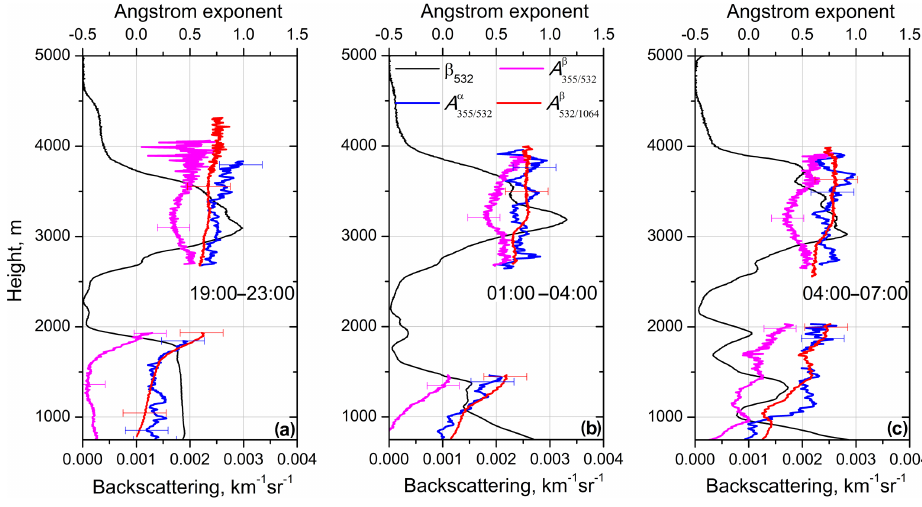
Figure 8. Extinction ( A α ) and backscattering ( A β , A β ) Ångström exponents together with backscattering coefficient β 532 355 / 532 355 / 532 532 / 1064 for the same three temporal intervals as in Fig. 7.